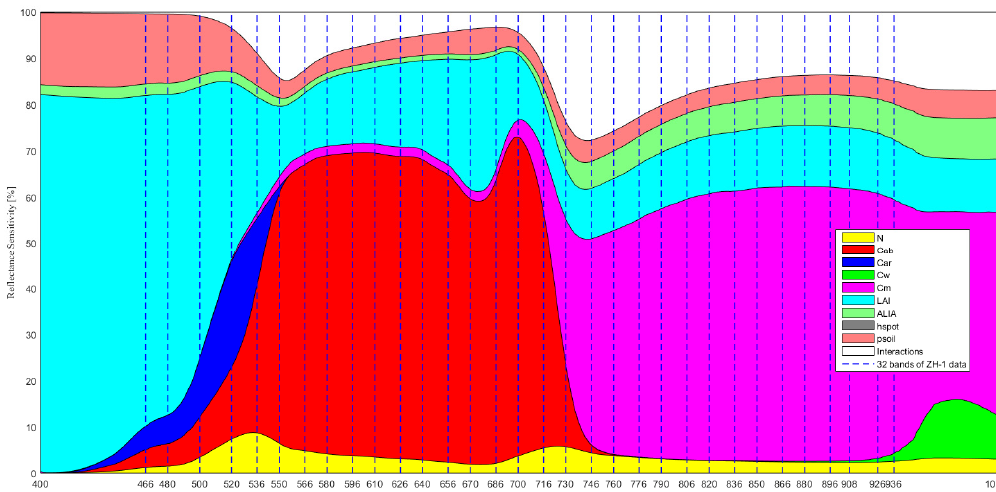
Figure 3. Global sensitivity analysis (GSA) of the PROSAIL model for canopy reflectance (The dashed lines represent the 32 bands of ZH-1 data. N: structure index, Cab: chlorophyll, Car: carotenoid, Cw: equivalent water thickness, Cm: dry matter per area, LAI: leaf area index, ALIA: average leaf inclination angle, hspot: hot-spot parameter, psoil: soil brightness factor. Table 2 shows the application units and input parameter ranges for GSA).